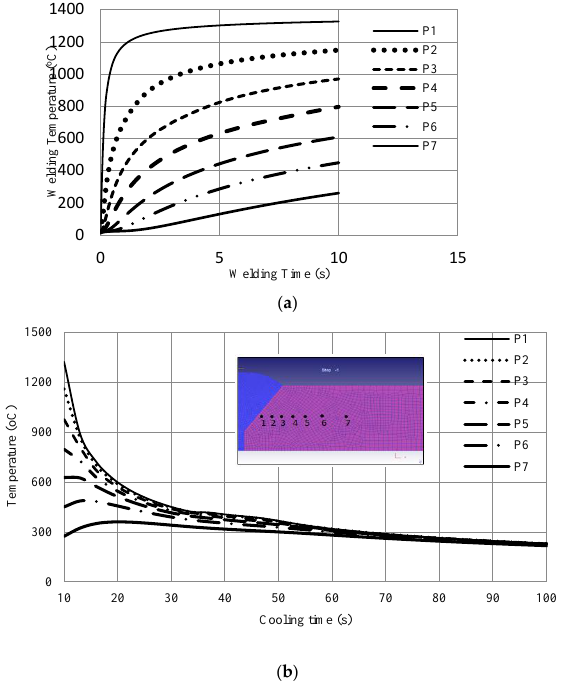
Figure 10. Temperature distribution of the HAZ region of the finite element model during ( a ) welding time and ( b ) cooling in still air. The microstructural evolution of the HAZ was determined by the FE model based on the TTT diagram and the cooling curves given in Figure 10. The formation of the martensite phase has been noticed at room temperature as is shown in Figure 11 during cooling stages in normal exposed air cooling processes. The maximum volume fractions of martensite are 0.256 in regions in Figure 11.